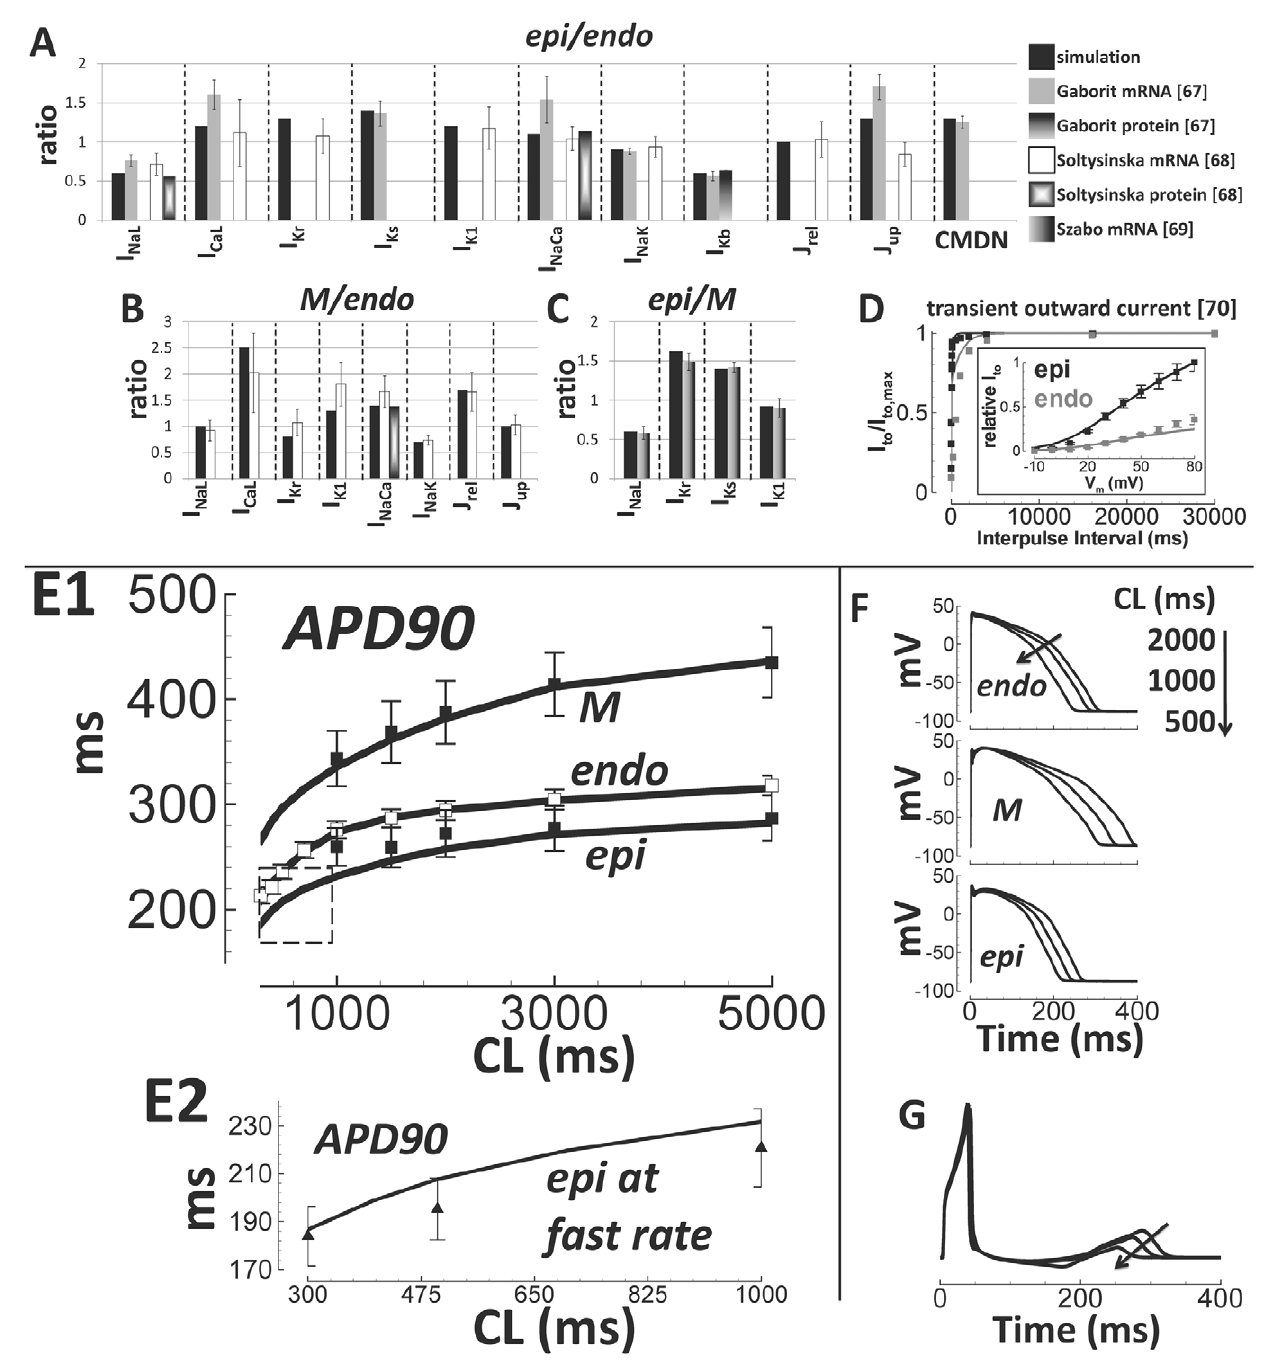
Figure 10. Transmural heterogeneity and validation of transmural cell type models. A–C) Expression ratio in the model (black bars) compared to experimental data from undiseased human hearts (grayscale bars, labeled). D) Transmural heterogeneity of I to ; simulations are lines, experiments are squares. Results for endo are gray; those for epi are black. E1) Rate dependence of APD90 in endo, M, and epi cell types. Epi and M data were obtained by scaling endo data (white squares) by epi/endo and M/endo APD90 ratios from Drouin et al.[50] (black squares). Simulations are black lines. E2) Same format as panel E1, showing epi APD90 at faster pacing rates. Data are from Glukhov et al.[71], (epi/endo scaling, black triangles). F) Top to bottom: Rate-dependence of endo, M, and epi APs. G) Pseudo-ECG, using a simulated transmural wedge. CL changes are indicated by arrows.